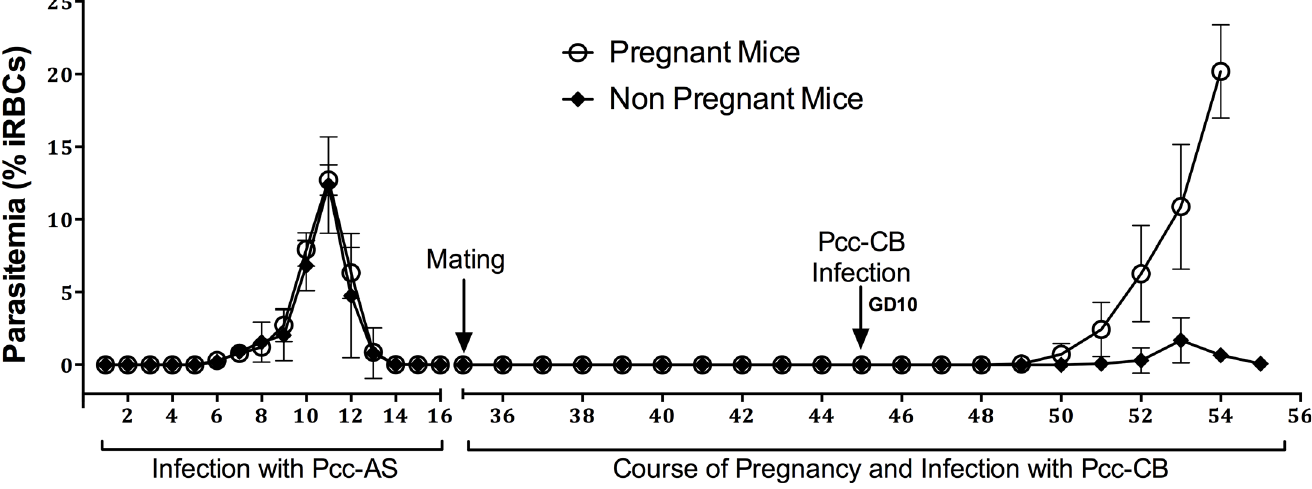
Fig 3. Course of parasitemia in pregnant versus non-pregnant mice re-infected with a heterologous strain of P . chabaudi . Mice were inoculated intravenously with Pcc- AS sporozoites, randomly assigned to be paired or not with males 36 days post-inoculation, and then injected with Pcc- CB iRBCs 46 days post-inoculation. Parasitemia was monitored by daily blood smears throughout the study. Data are presented as means with 95% confidence intervals. Similar results were obtained in two repeats of this